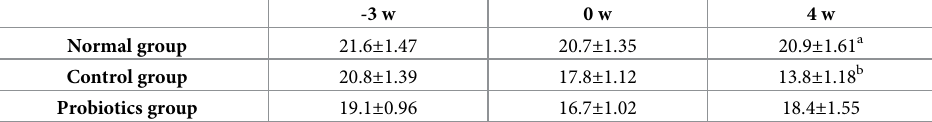
Table 5. The effect of probiotics treatment on acetate concentration in faeces ( μ mol/g) in adenine-induced CKD